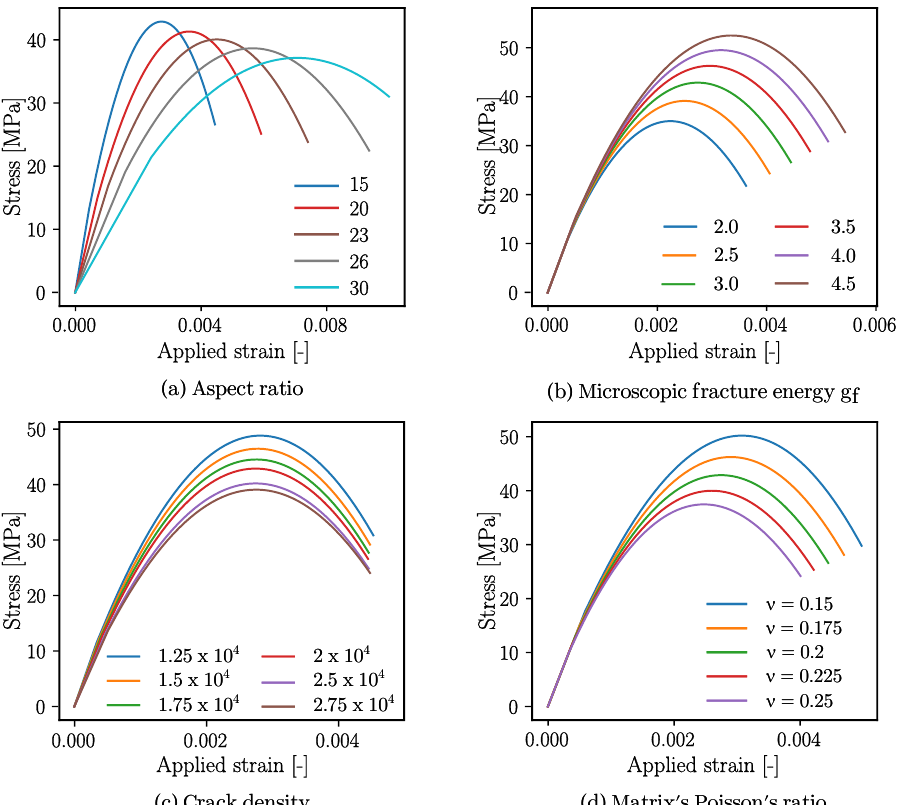
Figure A1. Parametric study: effect of model parameters at a microscopic scale on the compressive response of mortar